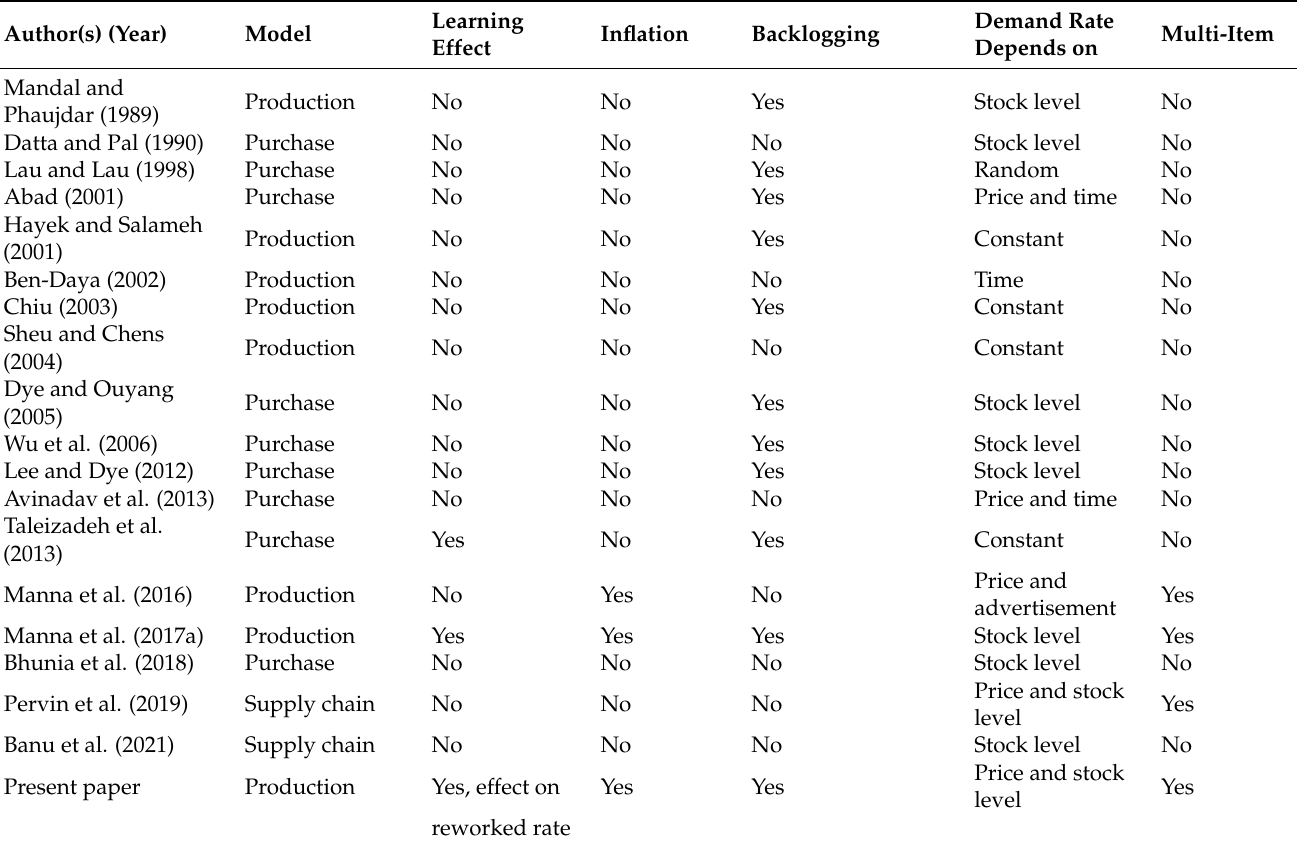
Table 1. Comparison of existing literature related with the current research